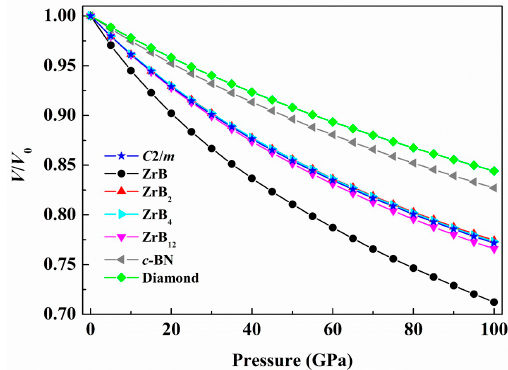
Figure 5. The calculated volume compression as a function of pressure for the C 2/ m -ZrB 3 in contrast to ZrB, ZrB 2 , ZrB 4 , c -BN, and diamond.